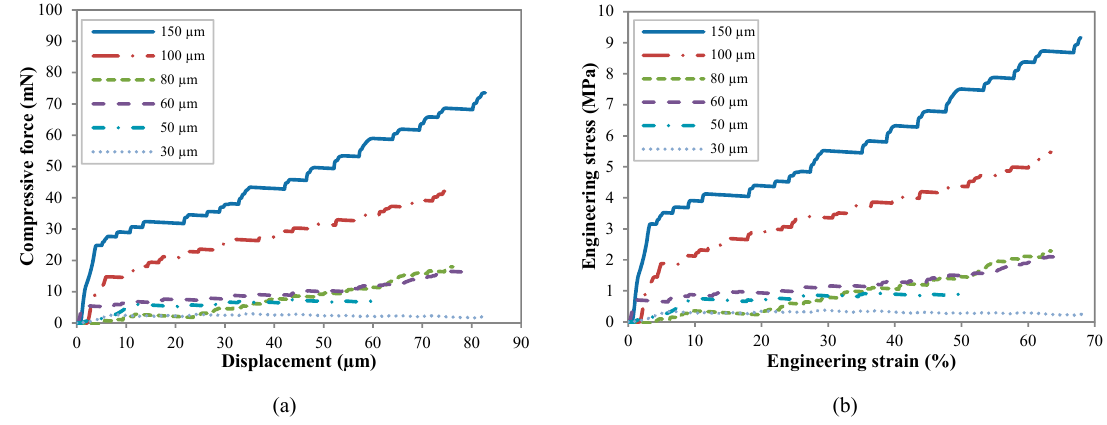
Figure 9. ( a ) Compression force-displacement and ( b ) stress–strain curves for 20 nm NbTiN coated CNT in various diameters.